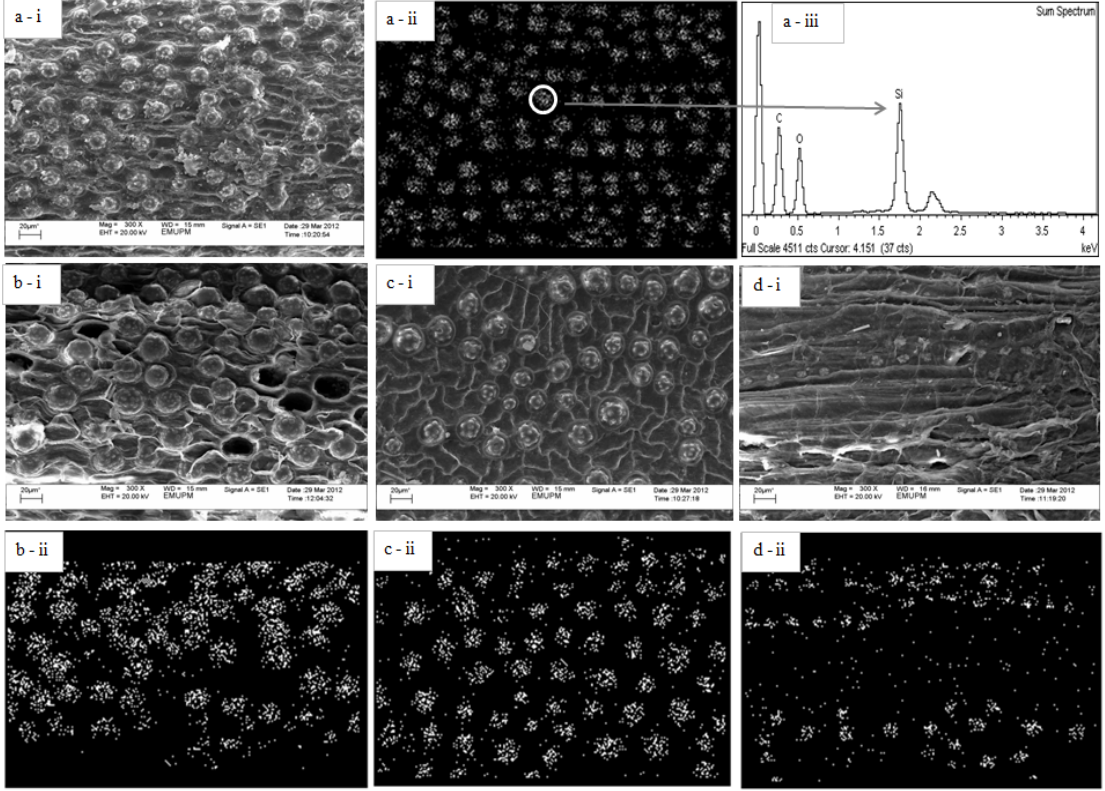
Figure 4. SEM images of untreated OPMF (a-i), SEM mapping of untreated OPMF (a-ii), microanalysis spectrum of untreated OPMF indicate the particle is silica (a-iii), SHS-treated OPMF at 190 °C (b-i & ii), 210 °C (c-i & ii) and 230 °C (d-i & ii) for 1 h, show reduction of silica bodies after SHS treatment.